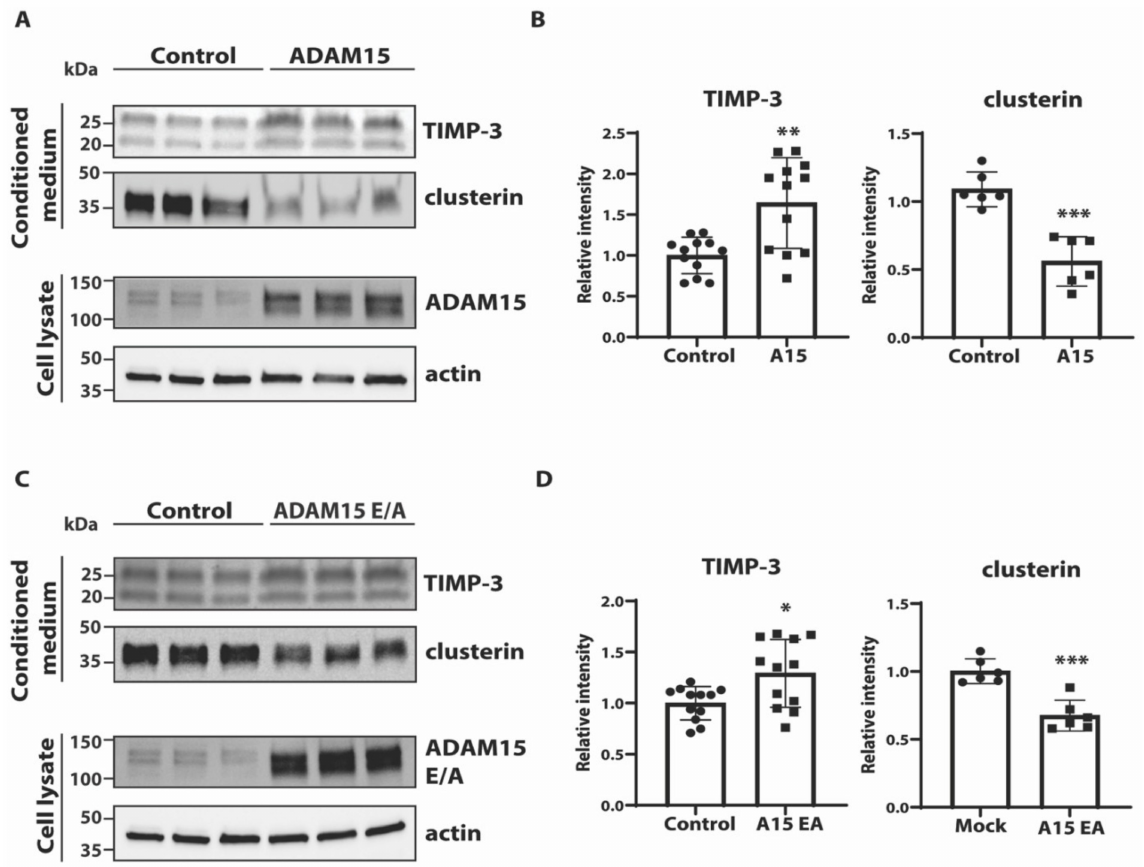
Figure 3. ADAM15 regulates levels of TIMP-3. ( A ) Levels of TIMP-3 and clusterin in the conditioned media and ADAM15 and actin in the cell lysates were evaluated by immunoblotting in ADAM15- overexpressing HTB94 cells and controls. ( B ) Densitometric quantifications of TIMP-3 and clusterin in the conditioned media of ADAM15 transfected and control cells are displayed as mean values ± standard deviation (* p < 0.05, ** p < 0.01, *** p < 0.005, Student’s t -test). ( C ) Similarly, levels of TIMP-3 and clusterin in the conditioned media, and ADAM15 and actin in the lysate of HTB94 cells transfected with ADAM15 E/A or controls were evaluated by immunoblotting and densitometric quantification ( D